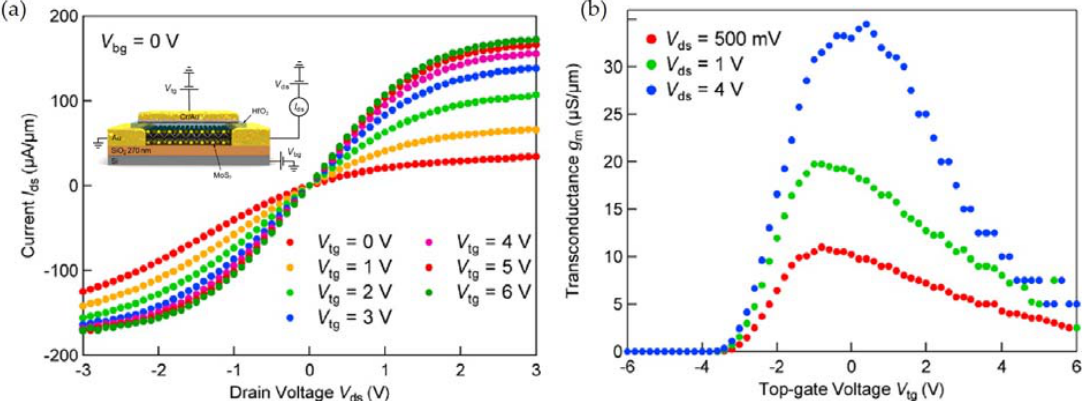
Figure 6. Performance of a high-transconductance MoS 2 FET. ( a ) I ds –V ds characteristics measured for different top-gate voltages V tg from 0 to 6 V. Inset: Three-dimensional representation of the monolayer MoS 2 FET ( b ) Transconductance derived from I ds –V ds characteristics at V ds = 0.5 V, 1 V, and 4 V. Reproduced with permission from [103], American Chemical Society, 2012.